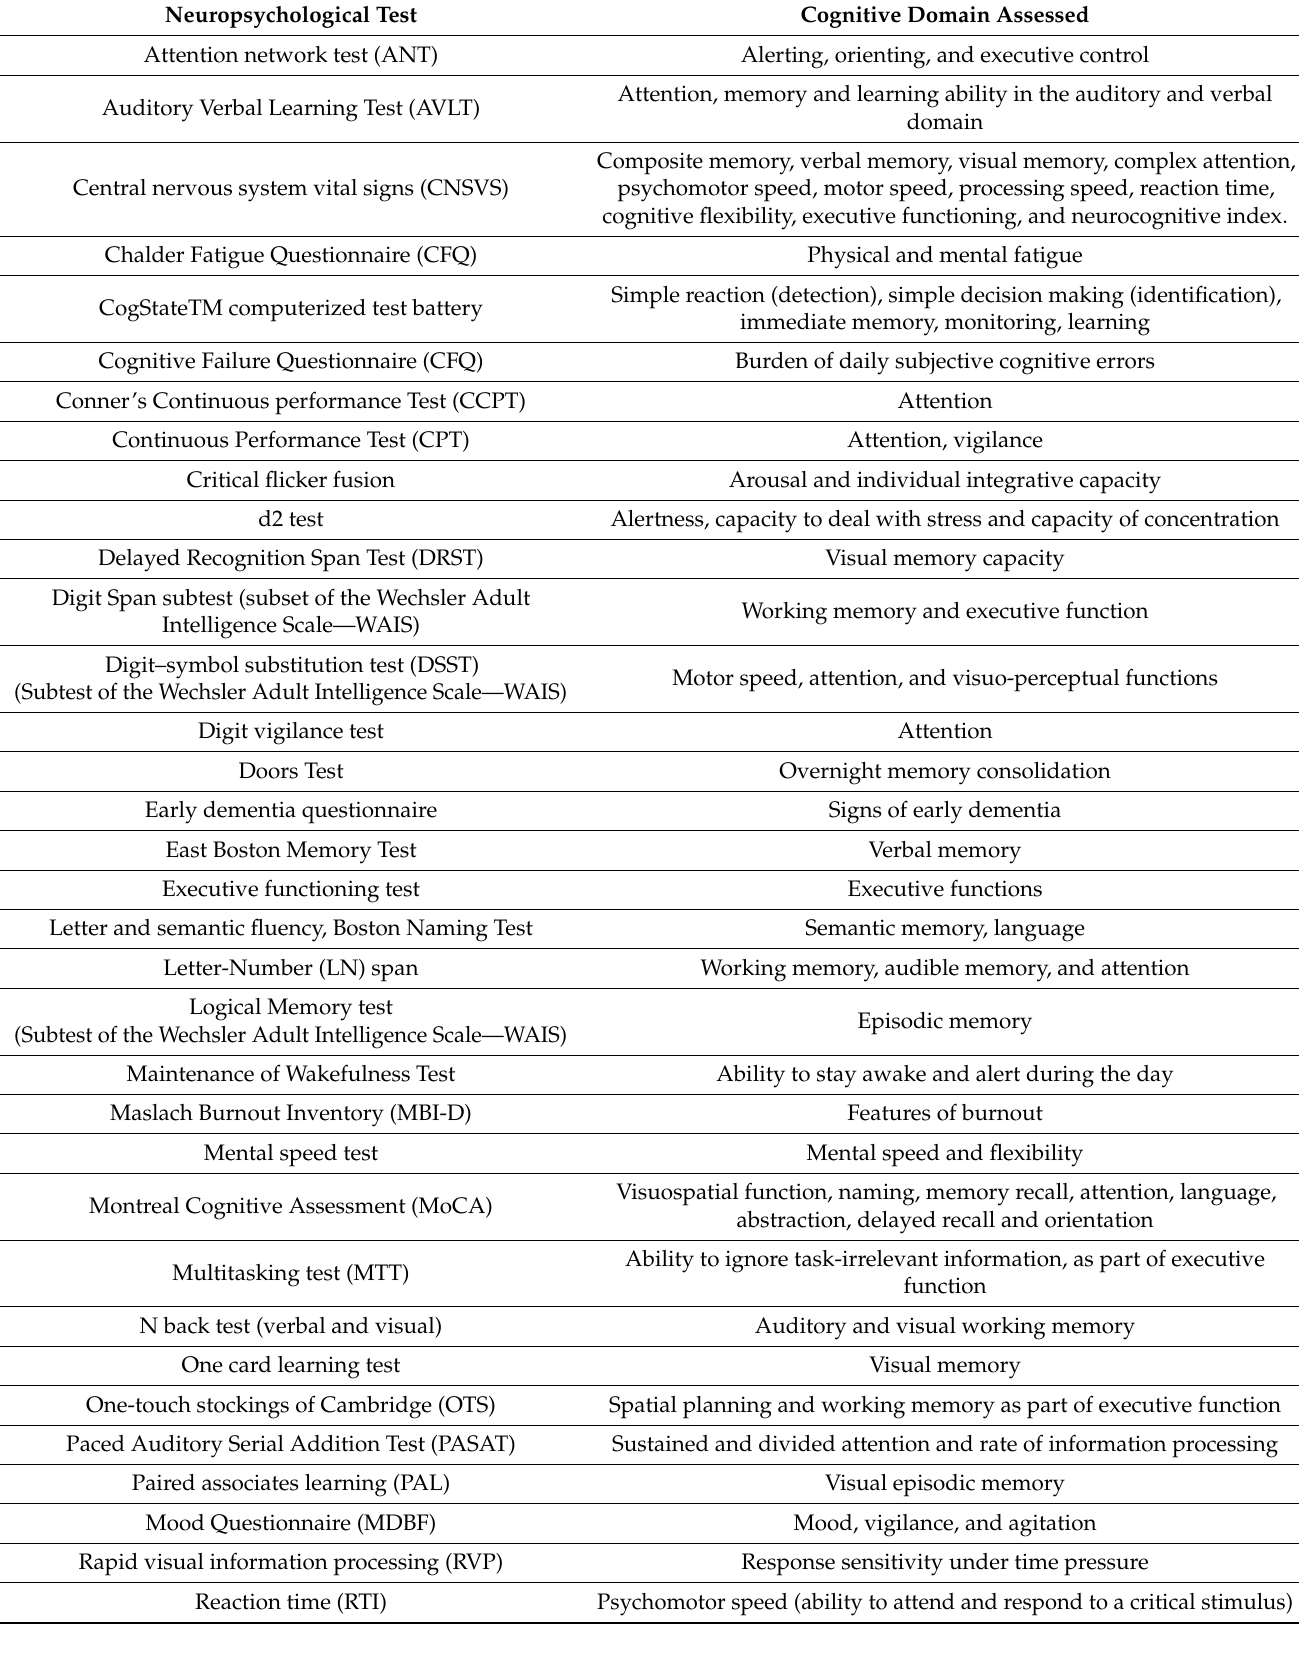
Table 1. Neuropsychological tests used in the studies included in the review and relative cognitive function